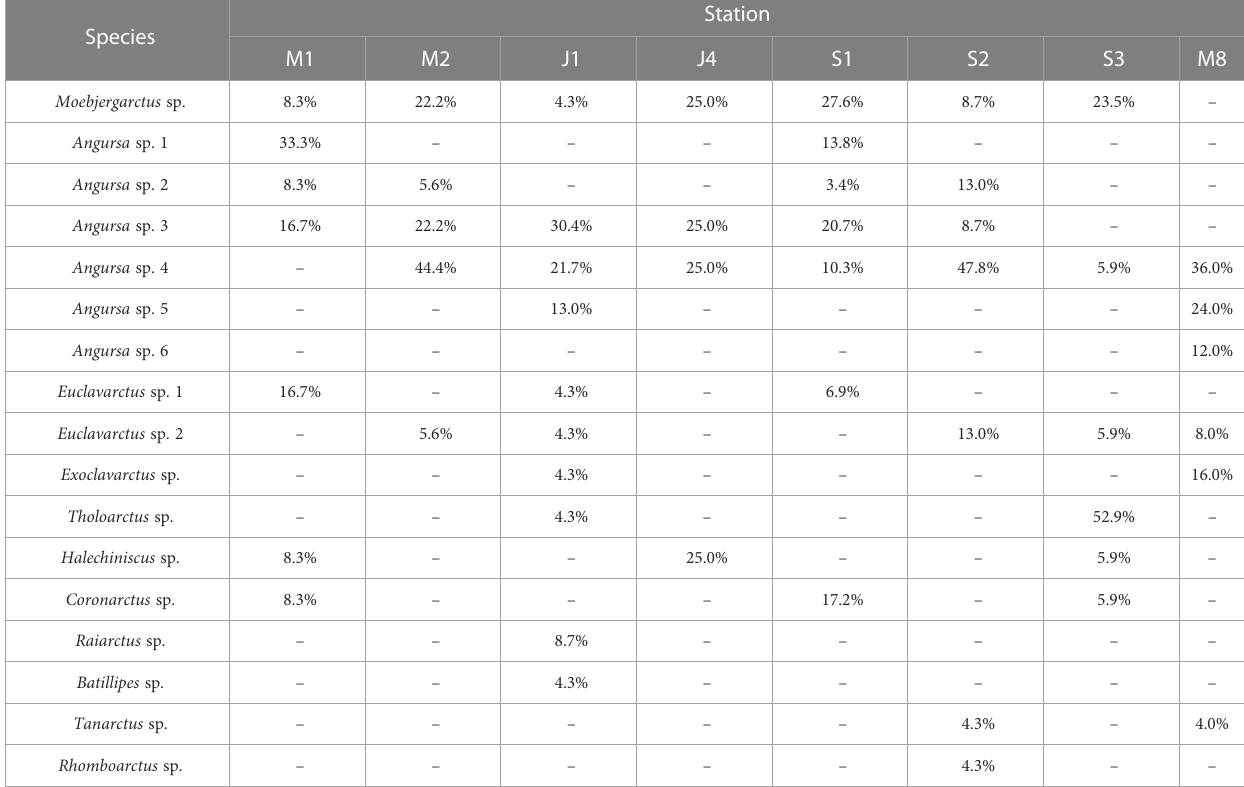
TABLE 5 Species composition of marine tardigrade fauna at different stations in the deep South China Sea.